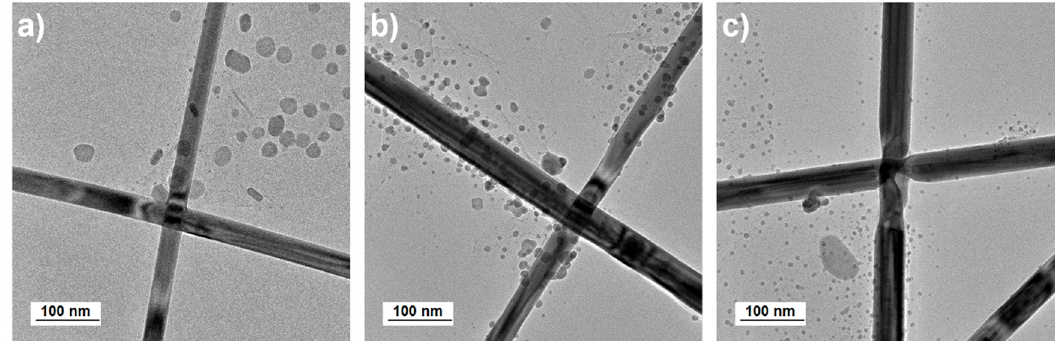
Figure 2. GCA-AgNW TEM image. ( a ) GCA 1:1 -AgNW not annealed, ( b ) annealed GCA 1:1 -AgNW, ( c ) annealed GCA 2:1 -AgNW.